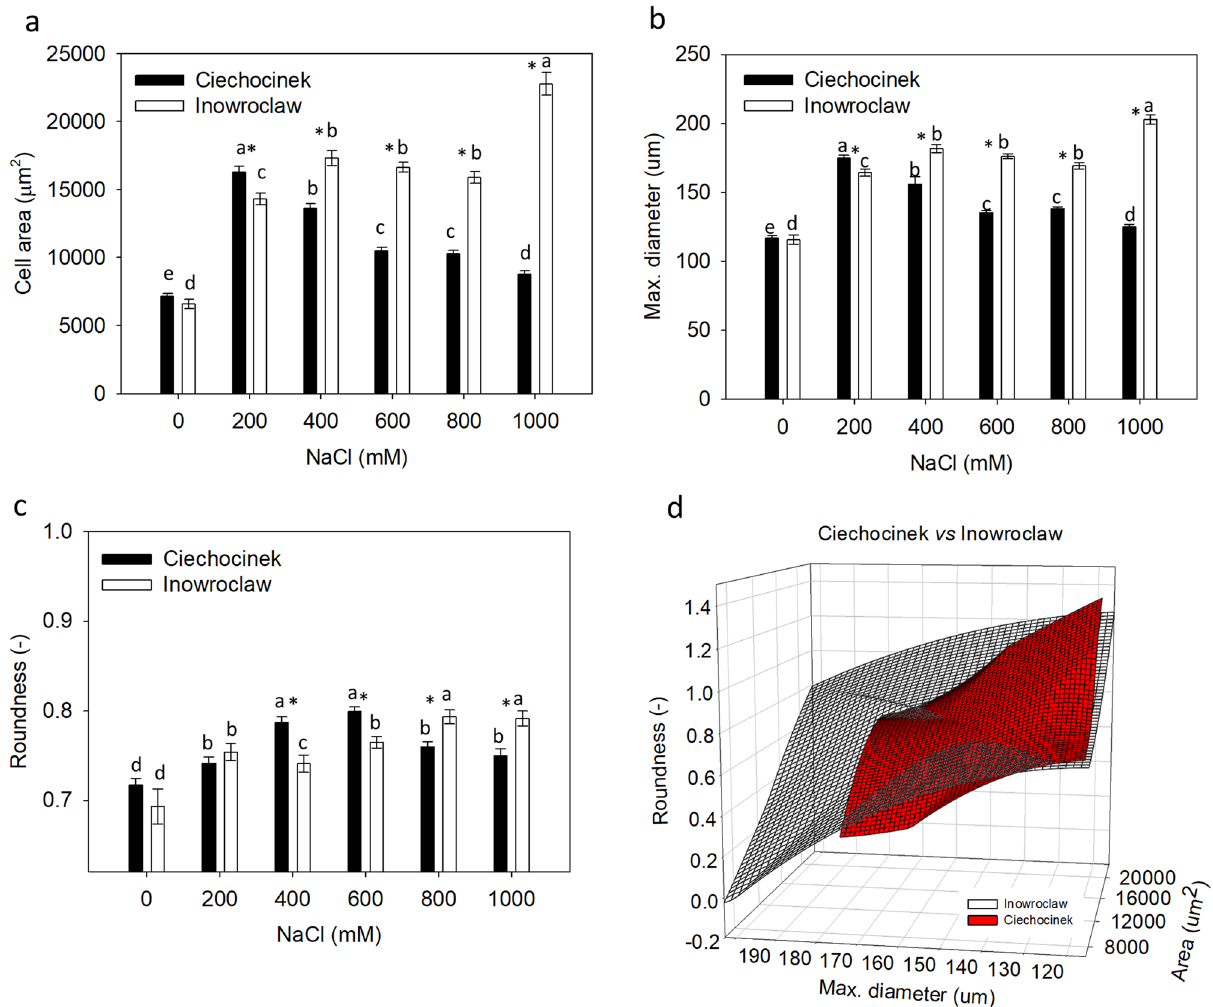
Figure 2. Morphometrical parameters ( a ) cell’s area, ( b ) maximum diameter, ( c ) roundness of the water storage cells in S. europaea populations (Inowrocław and Ciechocinek) under NaCl stress. ( d ) 3D plot compiling the three morphometrical parameters through the 6 salinity treatments. Means and ± SE of replicates. Different letters indicate significant differences between treatments within population and * indicates significant difference between populations within treatment ( p < 0.05), n = 300 ± 50 cells, 12 individuals per treatment. The F values that correspond to the 2-way ANOVA for the interaction of salt treatment × population are F 5,288 = 87.2, F 5,288 = 89.9, and F 5,288 = 9.7 for area, max. diameter and roundness respectively with a p <